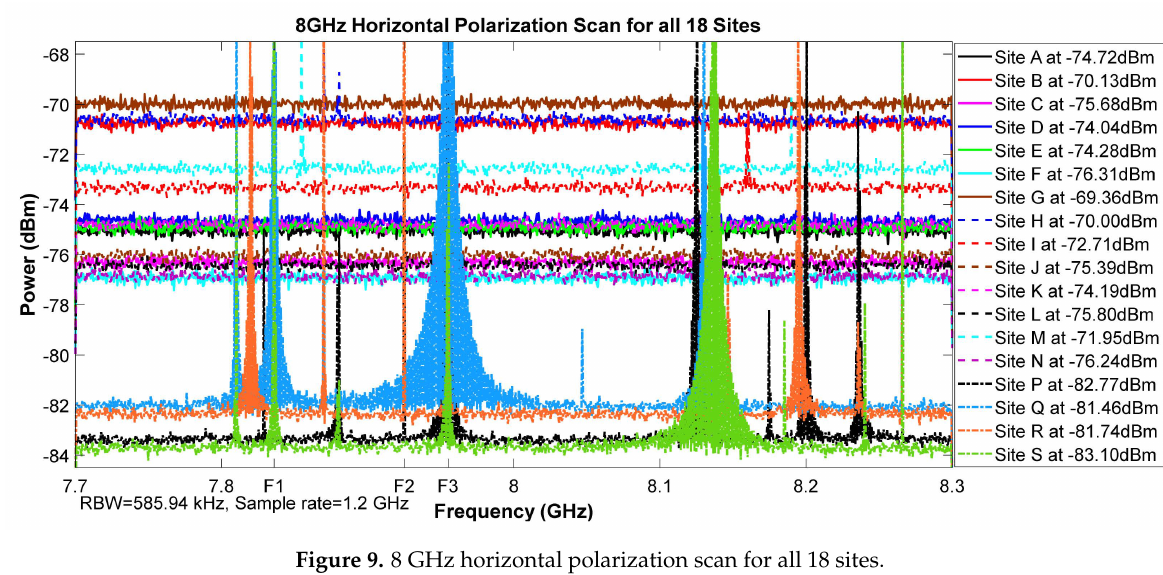
Figure 9. 8 GHz horizontal polarization scan for all 18 sites.